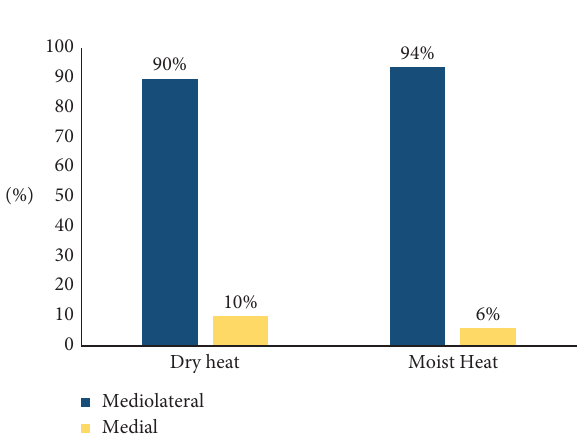
Figure 3: Graphical presentation of dry and moist heat groups according to their type of episiotomy.